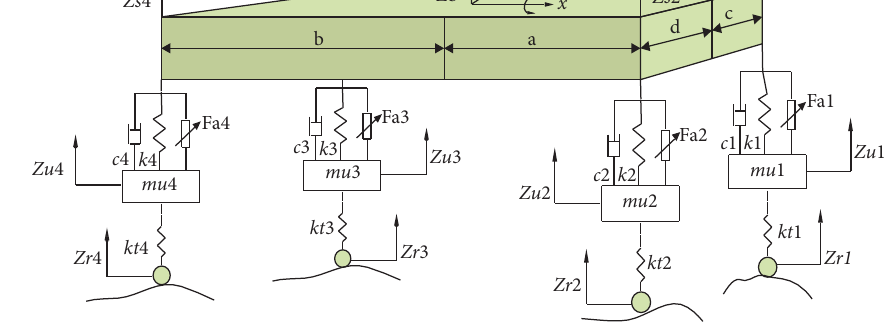
Figure 1: Active suspension